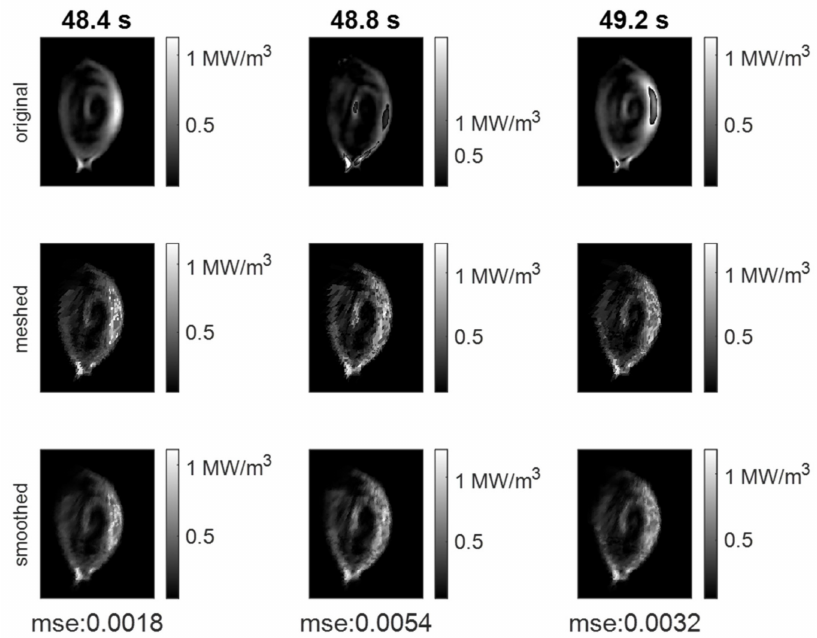
Figure 9. Tomographic reconstructions of three frames in the interval [48.1 s–49.5 s]. In the three rows the original images (top row), the meshed reconstructions (midrow), and the smoothed solutions (bottom row) are reported. The instants of occurrence of the frames are reported on the top, whereas the values of mse are reported on the